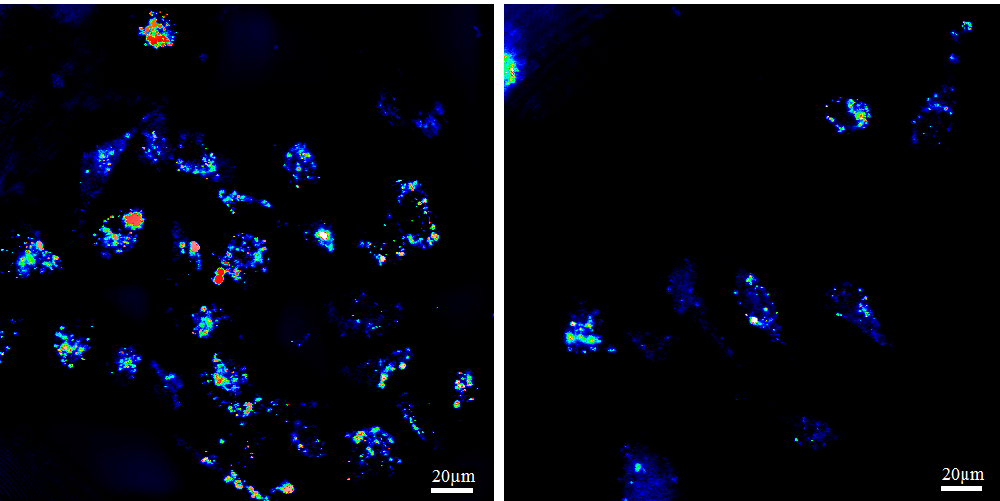
Figure 7. Cellular uptake comparison for 40 nm gold nanoshells ( left ) and Auroshell® particles ( right ) in PC3